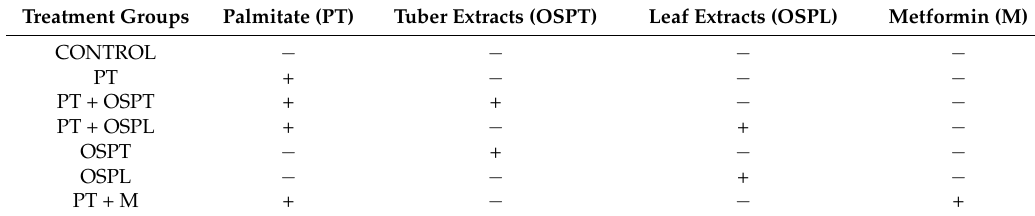
Table 4. Treatment groups for C2C12